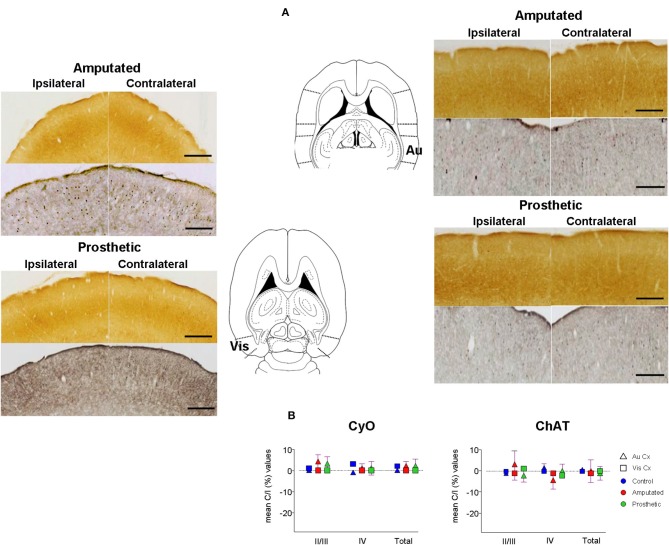
Metabolic activity and cholinergic innervation in auditory (Au) and visual (Vis) primary sensory cortices after amputation and after artificial stimulation of the infraorbital nerve. Deafferentation of the infraorbital nerve had no effects on the other primary sensory cortices. Also electrical stimulation had no effect. (A) Representative slides from the visual (left) and the auditory (right) cortex. CyO-reacted are on top and ChAT-immunostained are on bottom. Ipsilateral hemispheres are on the left, contralateral hemispheres are on the right. Drawings correspond to −3.86 and −3.10 from Bregma in horizontal diagrams according to the atlas of Paxinos and Watson (1998). In ipsilateral hemispheres rostral is right; in contralateral hemispheres, rostral is left; lateral is top. Scale bars = 200 μm for both CyO and ChAT. (B) Graphic representations of mean OD percentage changes of the contralateral vs. ipsilateral hemispheres indicated as C/I (%). Metabolic activity (CyO, left) and cholinergic innervation (ChAT, right) values of the visual and auditory cortices of control, amputated, and prosthetic animals (represented by blue, red, and green symbols, respectively) are given separately for cortical layers II/III and IV and the whole II-IV field. Values are expressed as mean ± s.e.m. No significant differences were found.